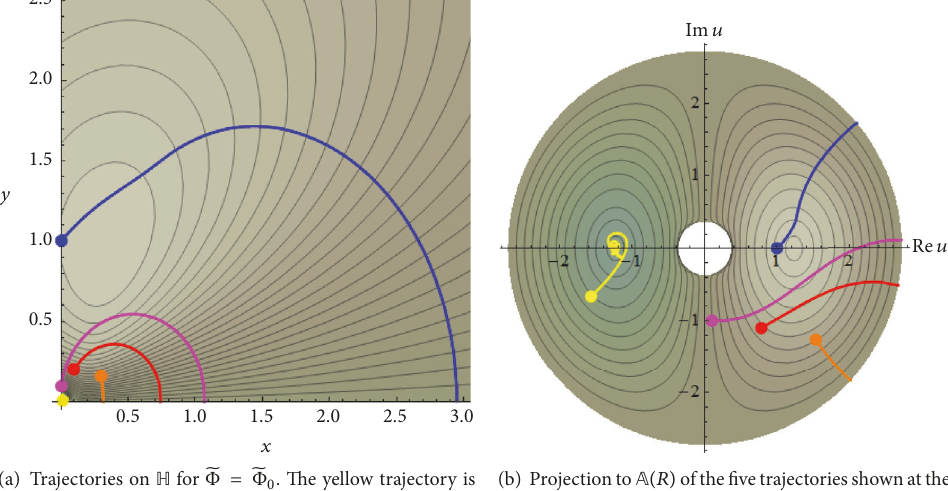
Figure 21: Five trajectories for Φ = Φ 0 when 𝛼 = 𝑀 0 /3 and ℓ = 𝜋 2 .